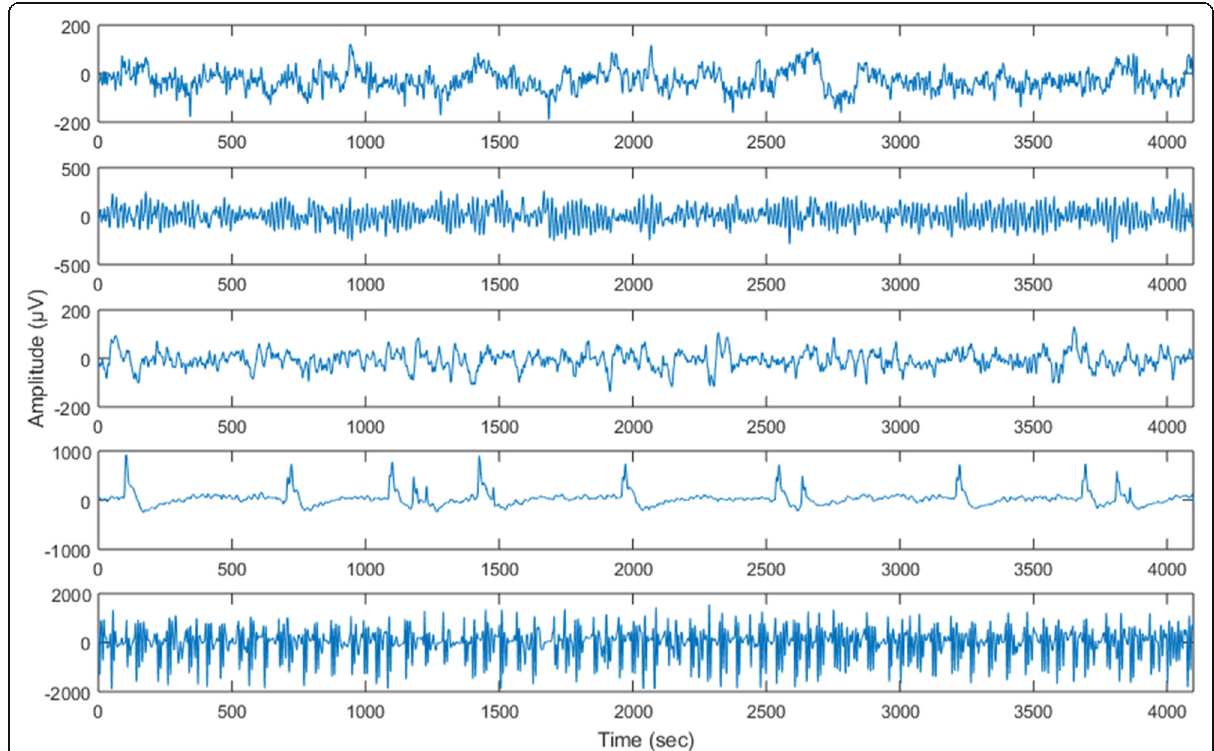
Fig. 1 Recordings from the five sets of the Bonn EEG